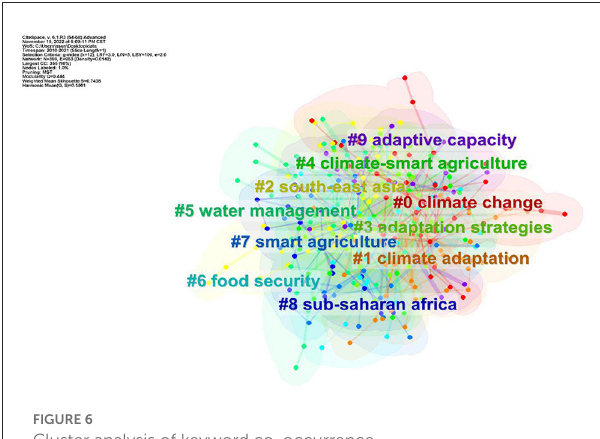
FIGURE6 Cluster analysis of keyword